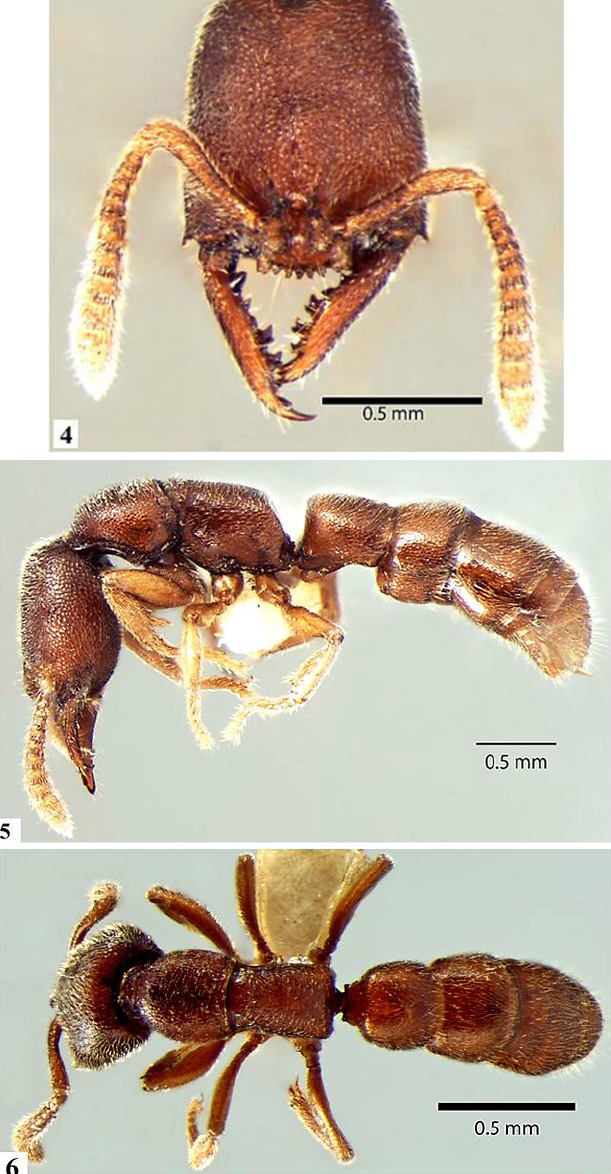
Fig 4-6. Stigmatomma awa (worker): 4. Head in full face- veiw; 5. Body in profile veiw; 6. Body in dorsal